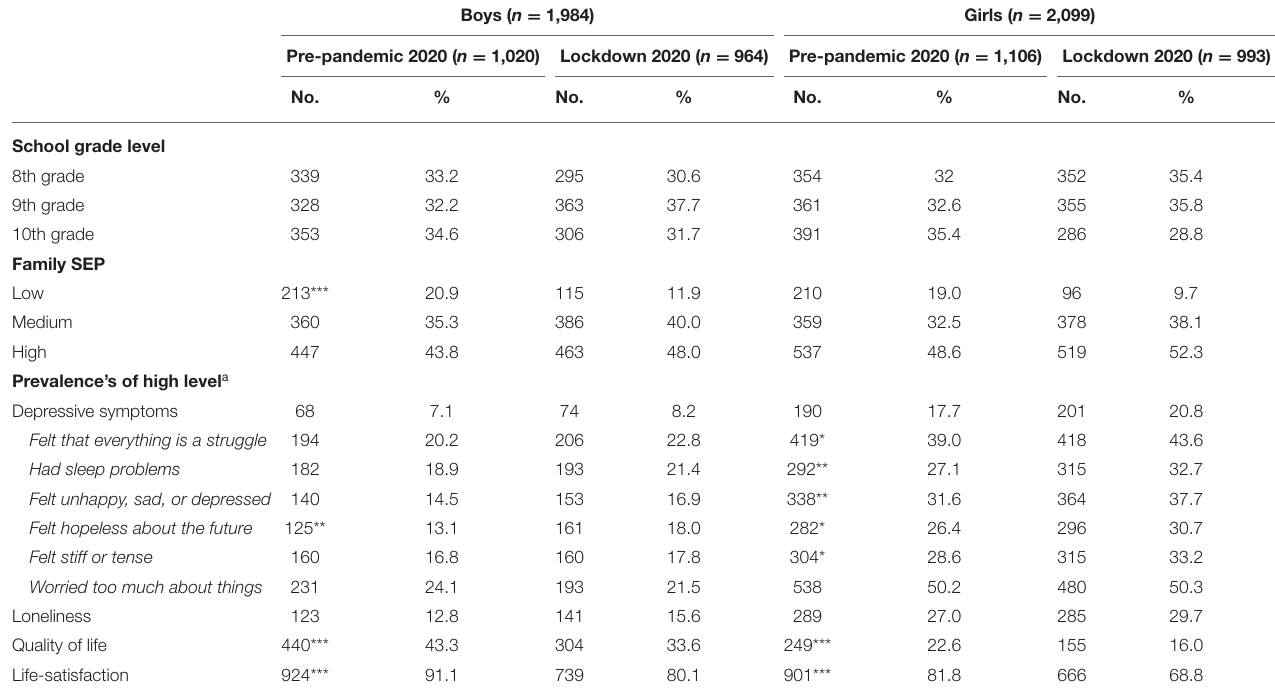
TABLE 1 | Study characteristics and prevalence is of high level of depressive symptoms, loneliness, quality of life, and life satisfaction among boys and girls in lower secondary education in Trøndelag County, Norway—before and after the lockdown in spring 2020.